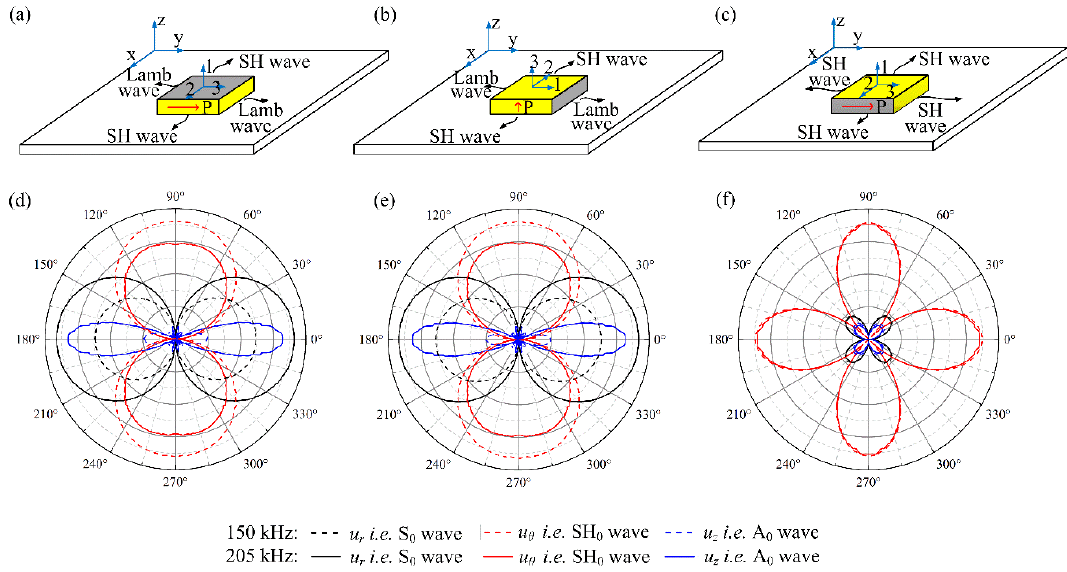
Figure 2. Group velocity verse frequency for SH 0 wave and Lamb waves in a 2 mm ‐ thick aluminum plate.